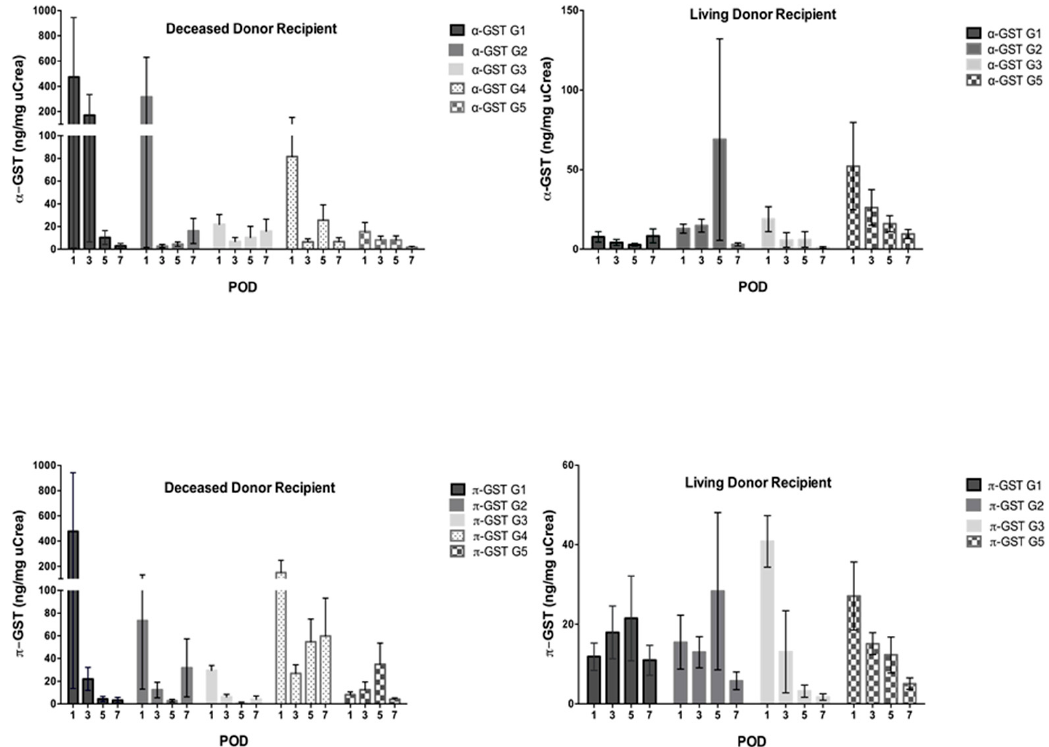
Figure 3. Urinary α - and π -GST levels in subgroups of deceased and living donor recipients during the first week after transplantation; G1: Acute graft rejection (AGR), G2: Calcineurin-induced nephrotoxicity (CNI), G3: Simultaneous acute graft rejection and calcineurin-induced nephrotoxicity (AGR + CNI), G4: Delayed graft function (DGF), G5: Event-free (control).